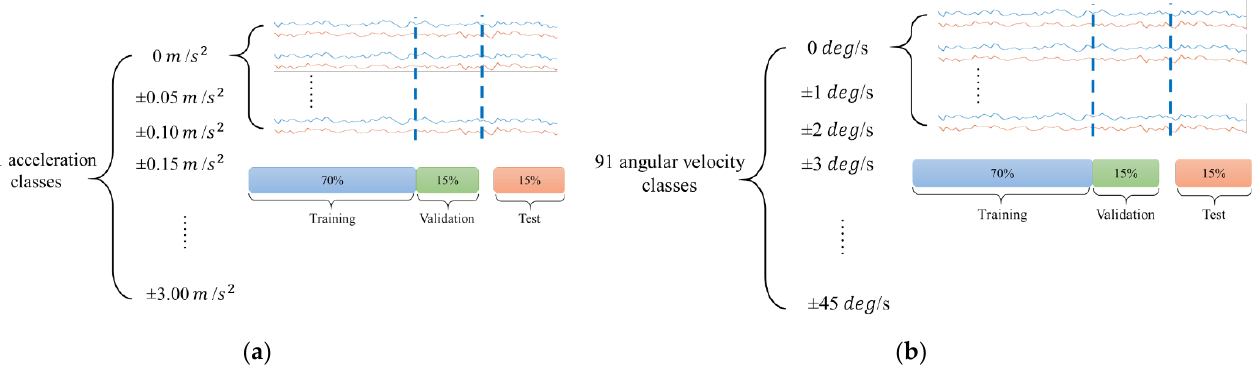
Figure 5. Collections of acceleration and angular velocity levels: ( a ) 121 acceleration levels collected from IMU; ( b ) 91 angular velocity levels collected from IMU.